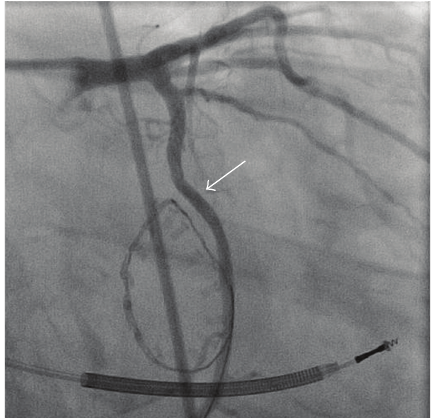
Figure 2: Final results of percutaneous coronary intervention with bare metal stent (arrow) of the previously distorted circumflex artery. Right anterior oblique with caudal